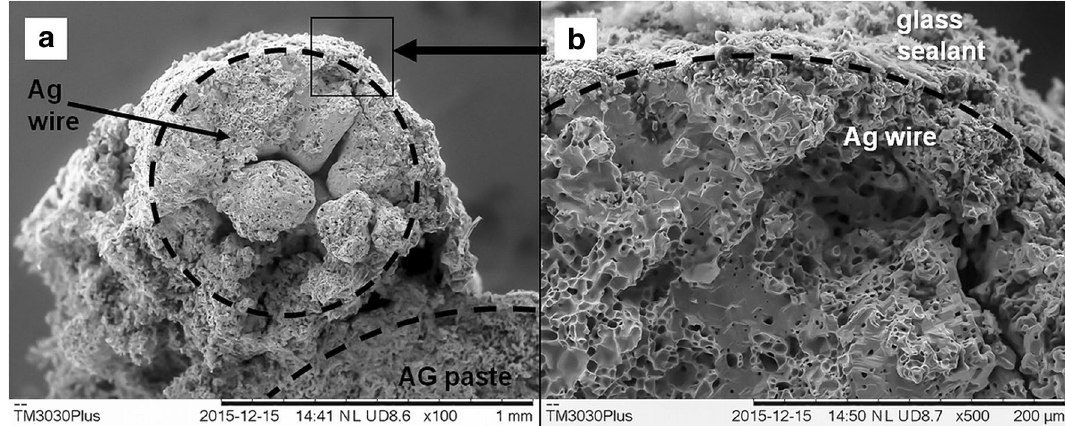
Fig. 4 SEM scans: a the cross-section of the anode current collection wire; b the cross-section of silver wire; after 850 h at 650 °C ~ 0.2 A cm −2 with CH 4 reformate as a